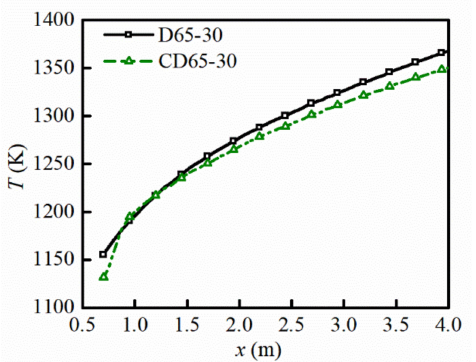
Figure 9. Temperature distribution of D65-30 and CD65-30 near the furnace